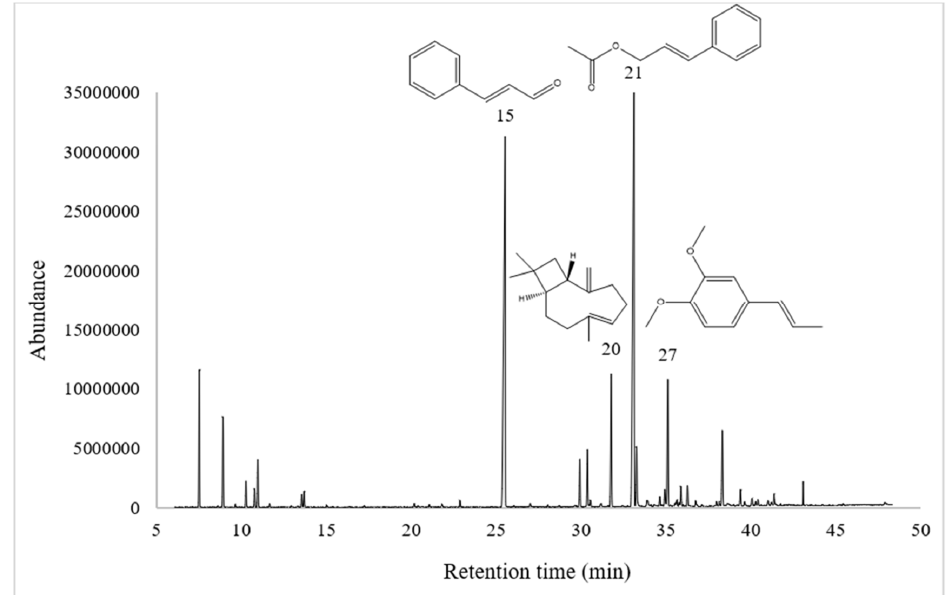
Figure 3. GC-MS chromatogram of O. quixos essential oil in DB-5ms column. Table 4. O. quixos leaf essential oil composition.